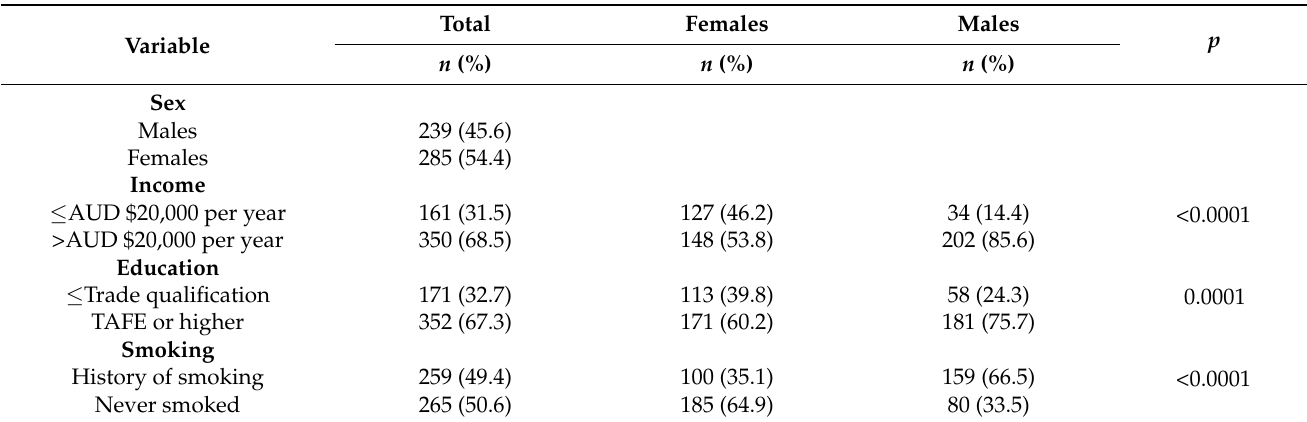
Table 2. Distribution of categorical variables by total cohort and by